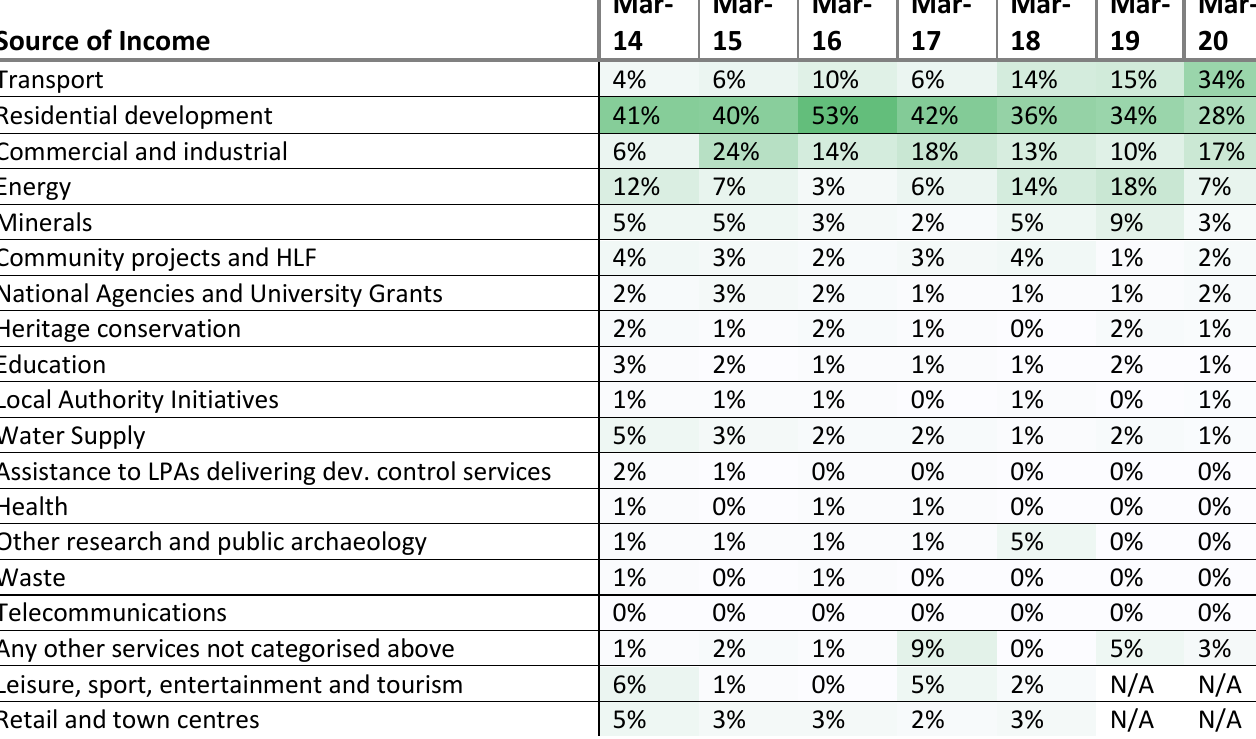
Table 16: Sources of income by sector from 2014 to